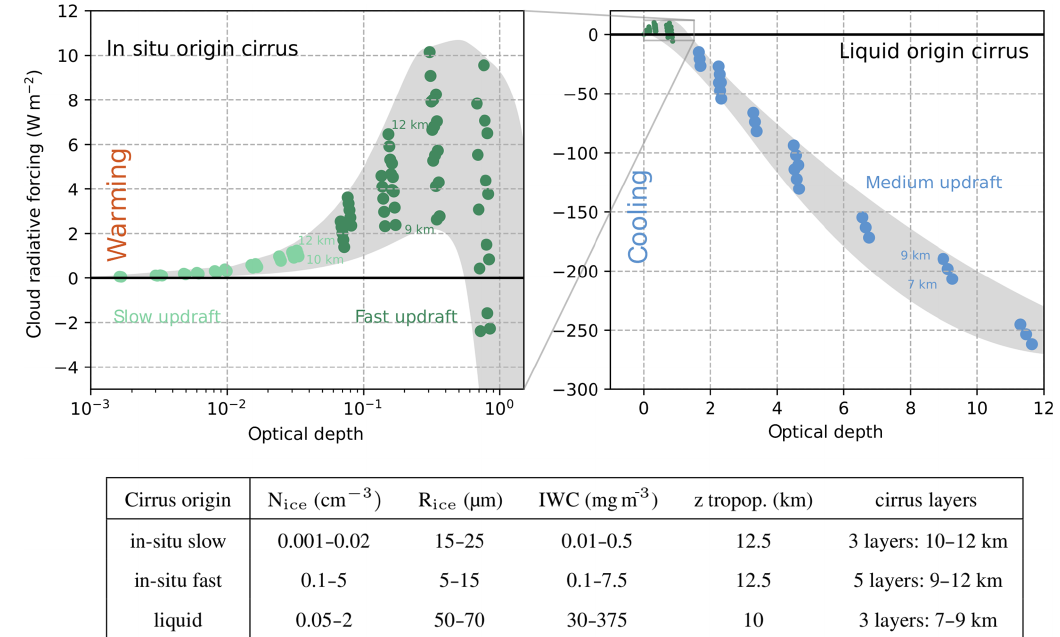
Figure 5. Simulated radiative forcing versus optical depth for exemplary in situ-origin slow- and fast-updraft cirrus (light and dark green dots) as well as liquid-origin cirrus (blue dots); the idealized scenarios are summarized in the table. Description of the idealized scenarios: a temperature profile is prescribed representative for midlatitude conditions; the surface temperature is set to 288K (at p = 1000hPa, p exponentially decreases with height). The vertical profile of relative humidity over ice is also established, with a saturated layer of 1000m thickness, constant subsaturation below the layer, and a strong decrease in humidity towards the stratosphere. A cirrus cloud with constant ice mass and number concentration is placed in the saturated layer. From the measurements (see Fig. 4), typical values of N ice , R ice and IWC are chosen for the three cirrus types (see table above). The vertical profiles are adjusted with respect to tropopause height ( z tropop.) and placement of the cirrus layers in accordance with the cirrus types. For the radiative transfer calculations, the well-known two-stream radiative transfer model for ice particles by Fu and Liou (1993), with 6 bands in the solar and 12 bands in the thermal infrared regime, is used. The simulations are realized for a geographic latitude of ϕ = 50 ◦ , solar surface albedo of 0.3, infrared surface emissivity of 1 and solar constant S = 1340Wm − 2 ; we assume equinox conditions (e.g., end of March) at local time t = 12h (for these settings, we use the modified model of Joos et al., 2014). The net cloud radiative forcing (CRF) is calculated using the fluxes at the top of atmosphere in the short wave and long wave ranges in comparison with a clear-sky